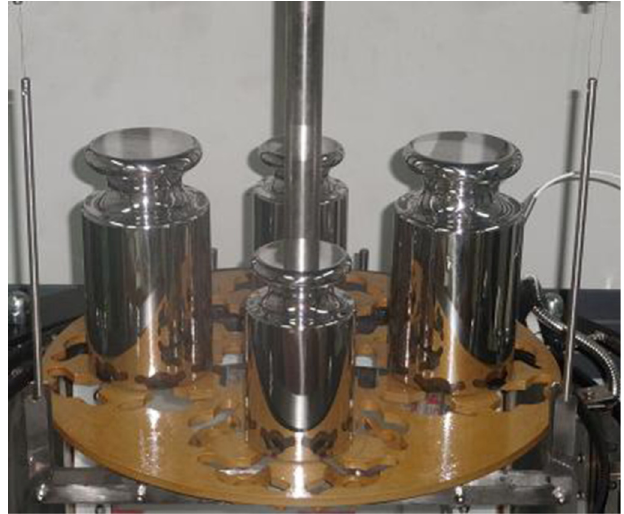
Fig. 12. The Von Misses stress distribution for the 4-Position Mass Handler.